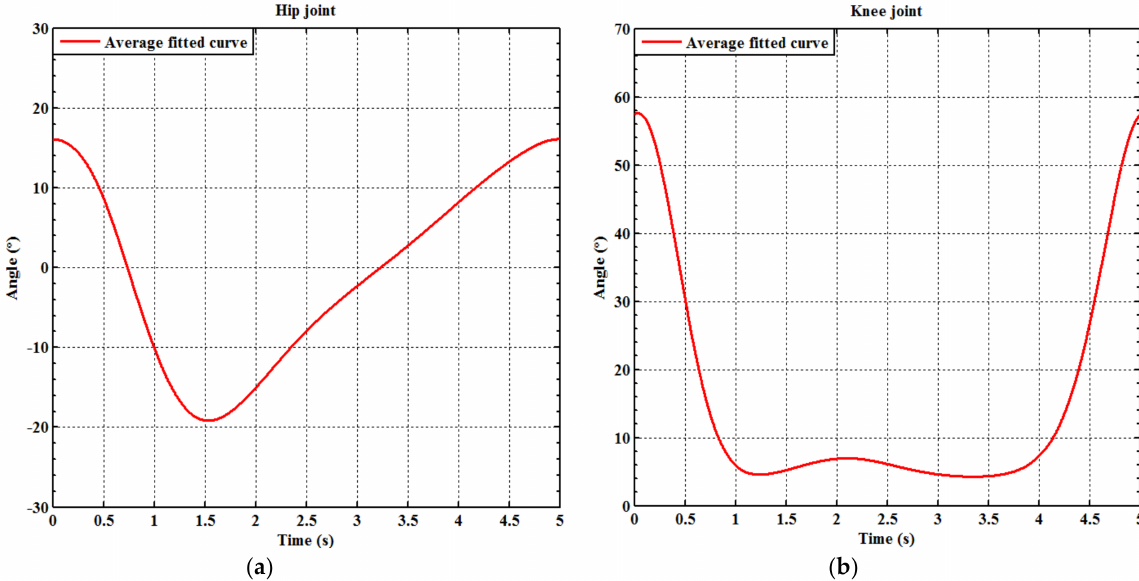
Figure 10. Average of the fitting curves of the full gait training cycle. ( a ) The hip of the right leg; ( b ) the knee of the right